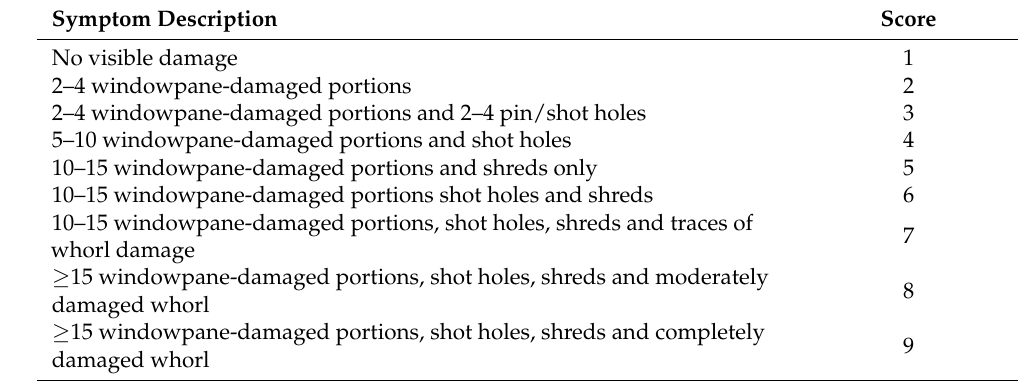
Table 3. Rating scale used to score maize genotypes artificially infested with FAW larvae in Zambia (Adapted from Davis, Ng & Williams, 1992